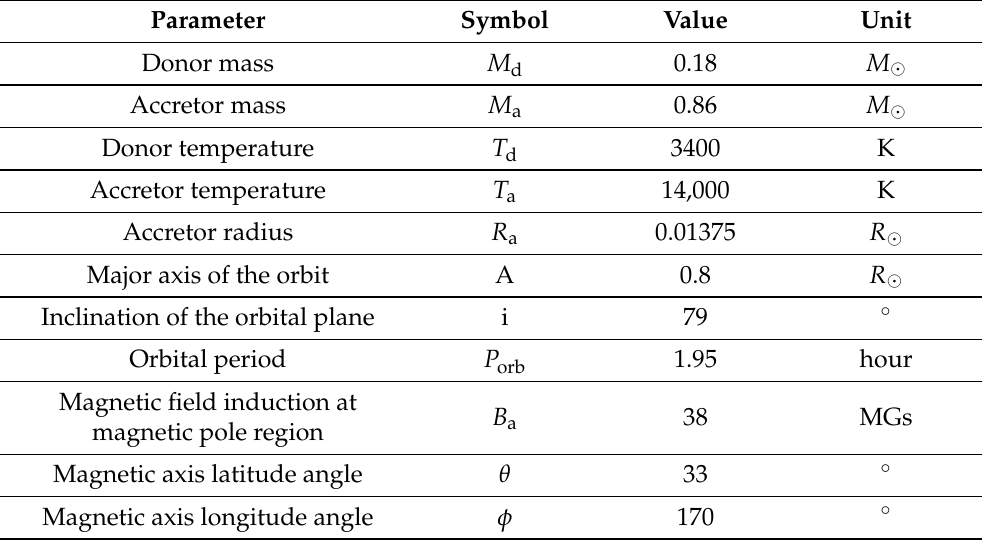
Table 1. Initial parameters for calculations of the synchronous polar V808